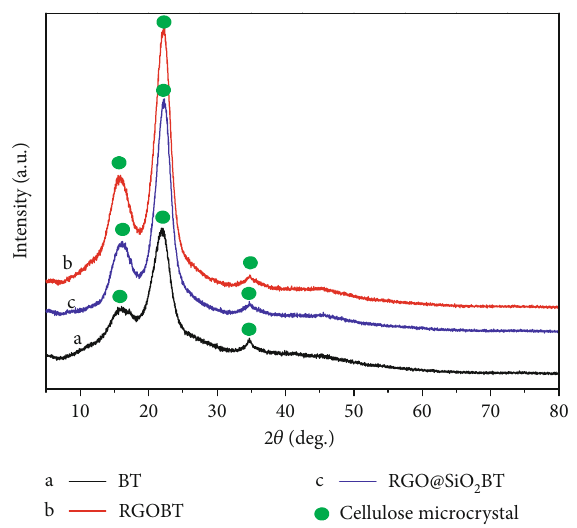
Figure 3: XRD pattern of BT (a), RGOBT (b), and RGO@SiO (c).